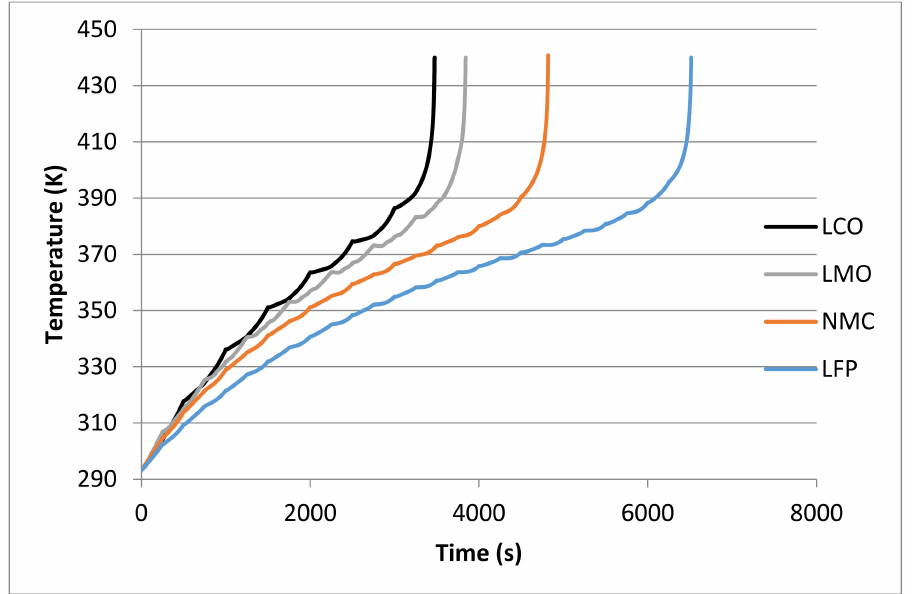
Figure 11. Temperature profiles as a function of time (h = 6 W/m 2